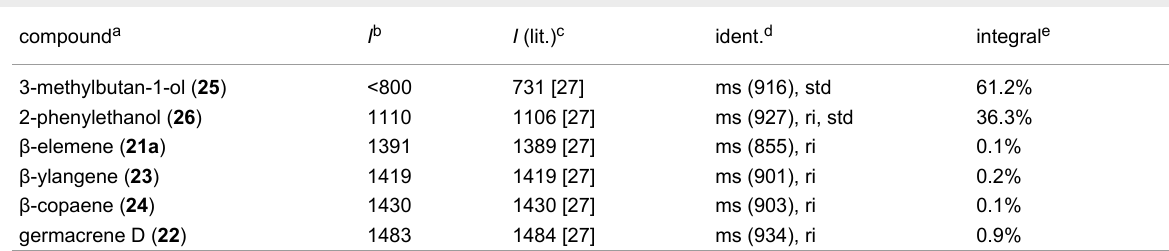
Table 2: Volatiles emitted by Aspergillus kawachii NBRC